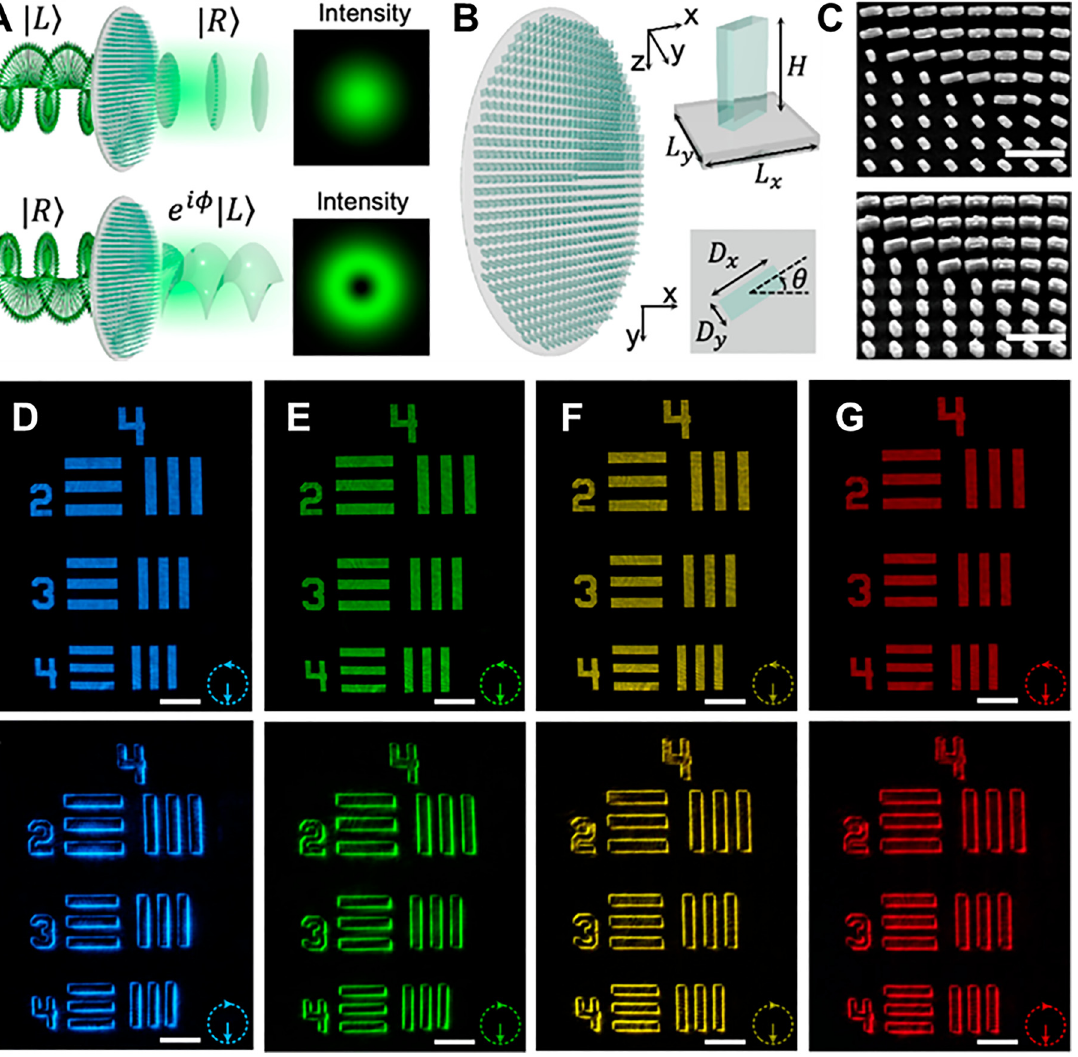
Figure 5: Vortex-phase metasurface for edge detection [132]. (A) The incident circularly polarized light passes through the metasurface, and the polarization chirality is reversed. For the incident RCP, the metasurface will produce a constant phase distribution and intensity distribution on the output beam, realizing a two-dimensional spatial differentiationoperation. (B)Schematicoftheall-dielectricmetasurfacespatialfilterdesignedtorealizephotonicspin-multiplexingfunction. Inset:PerspectiveandtopviewofametasurfaceunitcellformedbyamorphousTiO 2 nanopillarsonasilicasubstrate.(C)Topviewandoblique view of SEM image of TiO 2 nanopillar array. Scale bar: 1 μ m. (D) – (G) The bright fi eld images of the resolution test chart under the incident LCP lightandtheedge-enhancedphasecontrastimageswiththeincidentRCPlightatwavelengthsof480,530,580,and630nm.Theinsetshows the handedness of the incident light. Scale bar: 100 μ